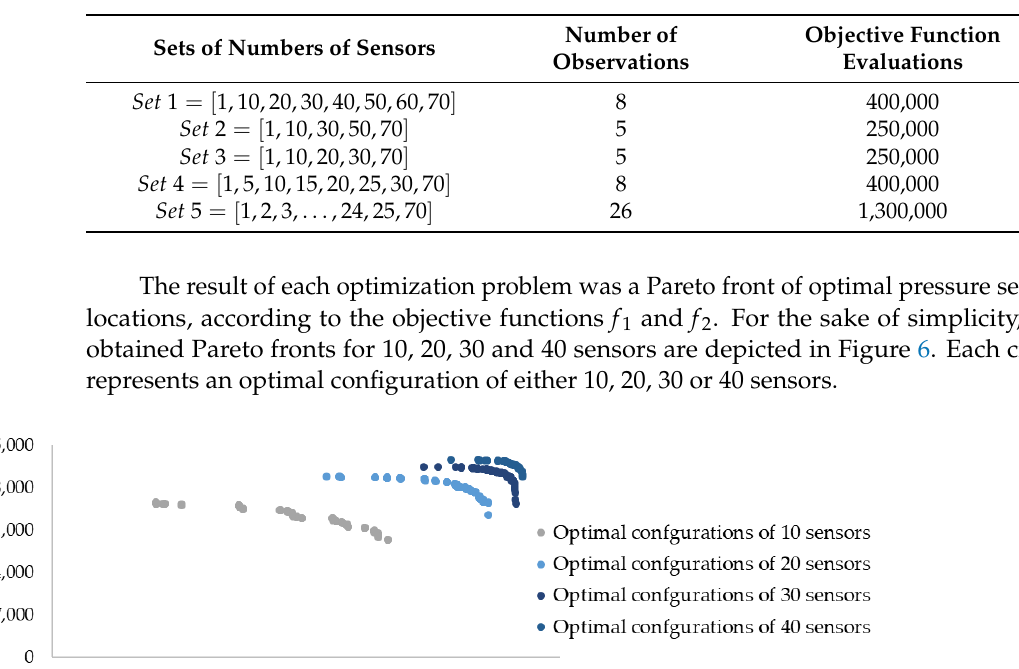
Table 1. Number of objective function evaluations for each discrete set.